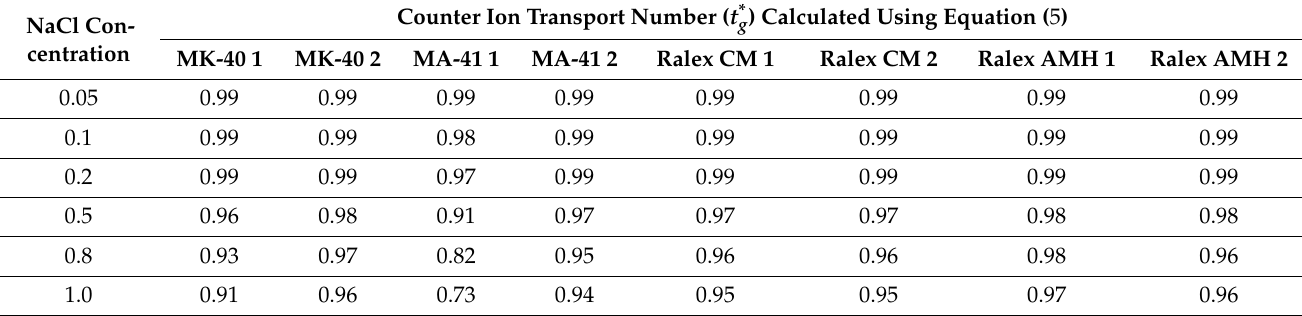
Table 5. Calculated counterion transport numbers for the studied ion-exchange membranes. NaCl Con- centration MK-40 1 MK-40 2 MA-41